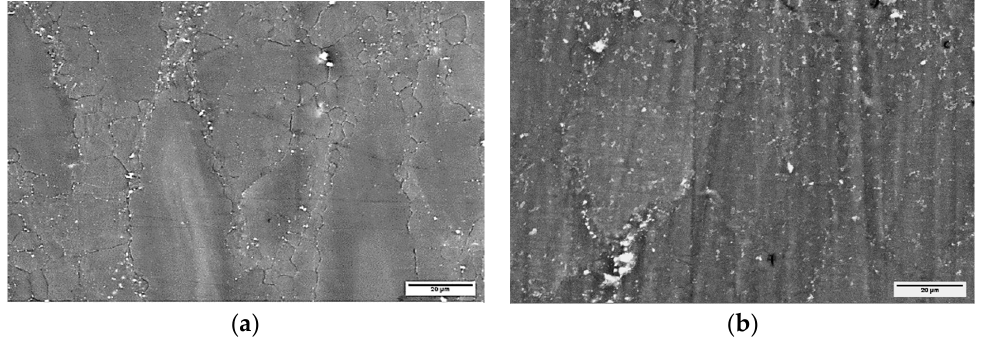
Figure 6. SEM images of the microstructure of ( a ) ED and ( b ) ED + HT.